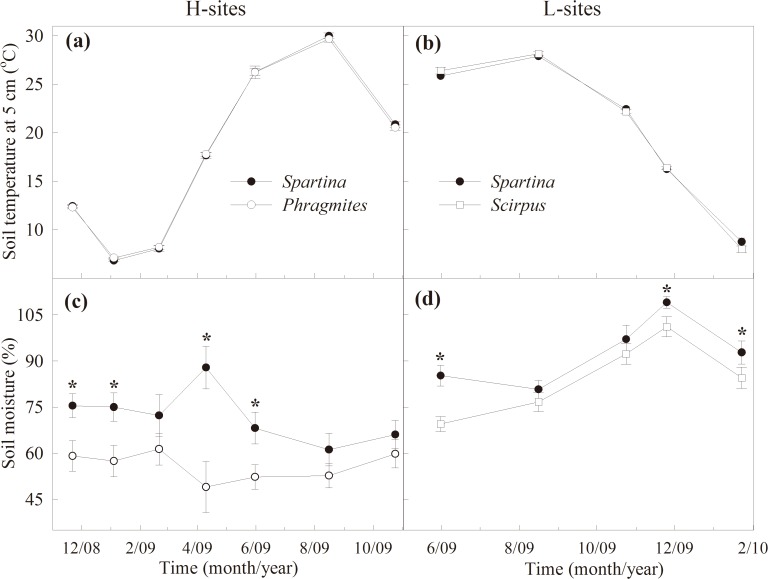
Temporal variations in soil temperature and moisture in different plant stands.Temporal variations in soil temperature (a, b) and moisture (c, d) at 0–5 cm depth in the S. alterniflora (Spartina) and P. australis (Phragmites) stands in the H-sites, S. alterniflora and S. mariqueter (Scirpus) stands in the L-sites. Bars represent mean ± SE (n = 9), asterisks indicate significant differences (P < 0.05) between means of different stands.